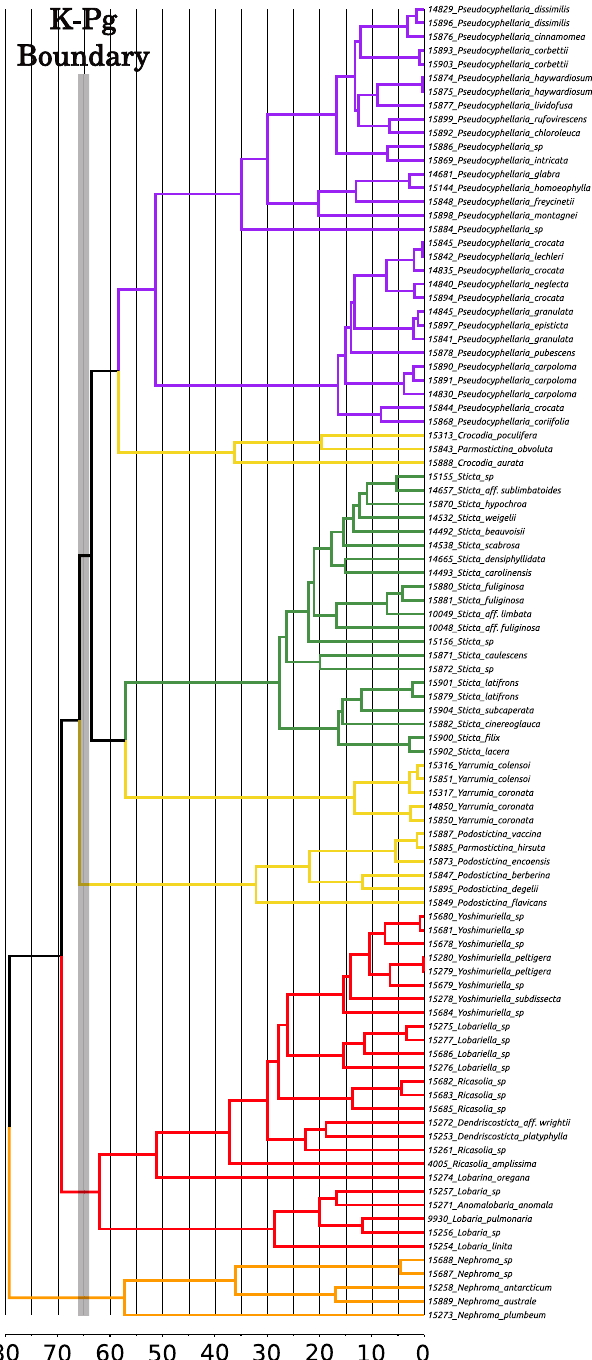
Figure 7. A chronogram estimated by Bayesian relaxed molecular clock implemented in MCMCTree. The ML tree inferred with concatenated amino acid sequences (376 × 96 aa - congruent with the ASTRAL species tree) was used a scaffold for the dating analysis. The grey vertical bar depicts the K-Pg boundary. The timescale is in units of millions of years. Colors of clades: Orange: Nephroma (outgroup); Red: Anomolobaria , Dendriscosticta , Lobaria , Lobariella , Lobarina , Ricasolia , Yoshimuriella ; Yellow: Crocodia , Parmostictina , Podostictina , and Yarrumia (not monophyletic); Green: Sticta ; Purple: Pseudocyphellaria